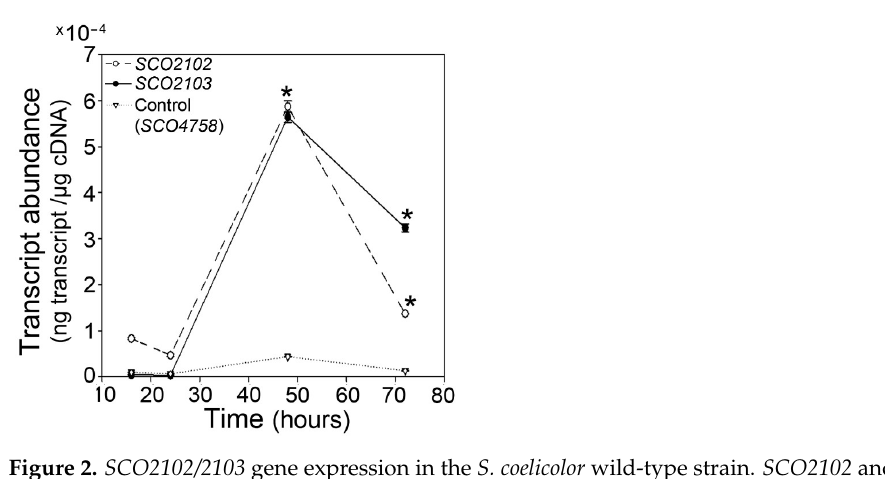
Figure 2. SCO2102/2103 gene expression in the S. coelicolor wild-type strain. SCO2102 and SCO2103 transcript abundance in GYM solid cultures. Asterisks indicate significant differences compared to the 16 h sample. Transcript abundance of the SCO4758 housekeeping gene [20] was used as control. Three biological replicates were processed.